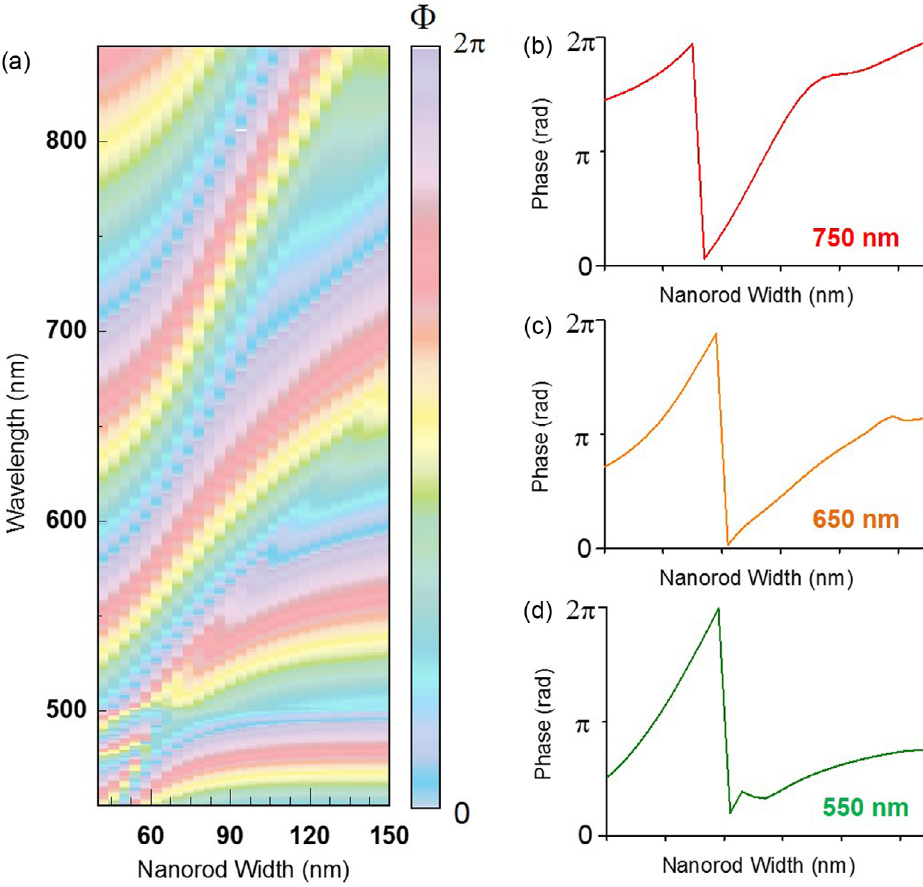
Figure 2. (a) Simulated 2D contour for phase shifts of nanorods as a function of width size and wavelength. (b–d) Simulated phase shift plots as a function of nanorod width at wavelength of 750 nm, 650 nm and 550 nm, respectively.